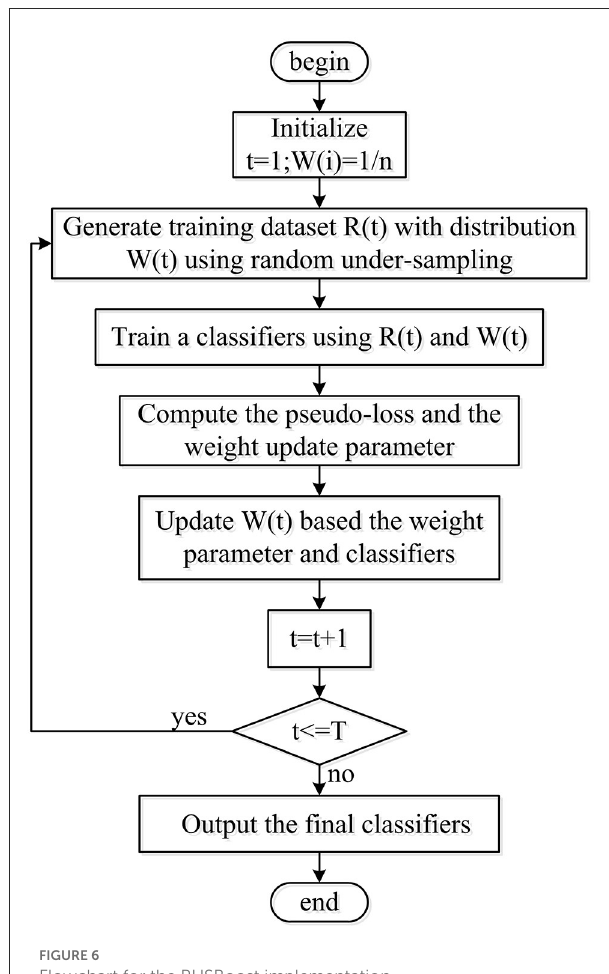
FIGURE6 Flowchart for the RUSBoost implementation.